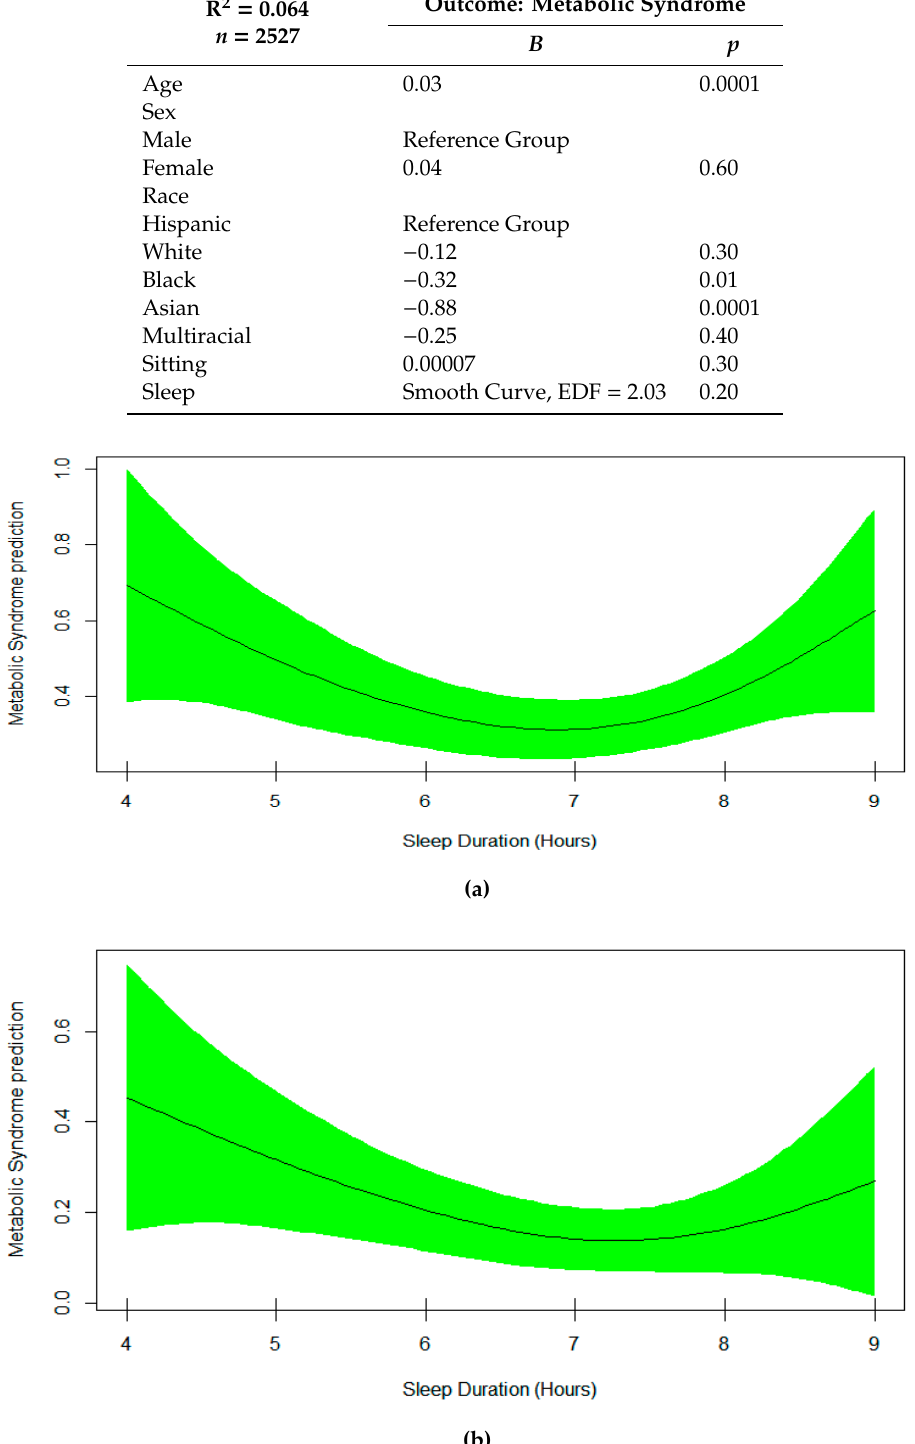
Figure 1. Plots of estimated smoothing spline function of sleep duration with 95% confidence band for the generalized additive model when the response variable was metabolic syndrome. ( a ) Model 1 shows the univariable smooth function of sleep duration (EDF = 2.428, p = 0.06). ( b ) Model 2 represents the multivariable smooth function of sleep duration (EDF = 2.03, p = 0.20).